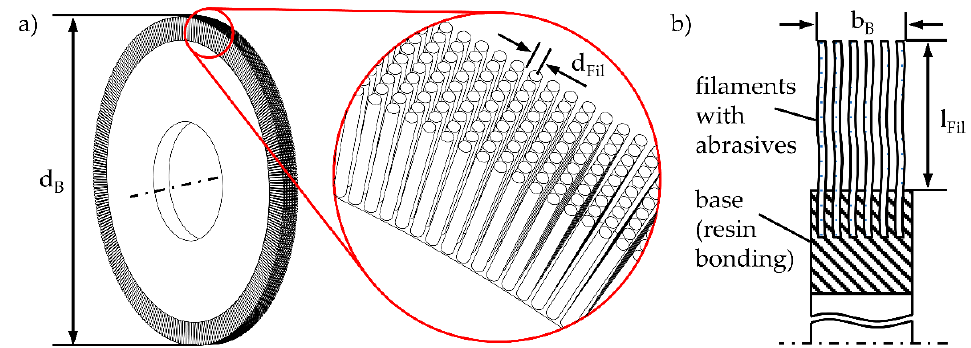
Figure 2. Design of an abrasive brushing tool; ( a ) 3 ‐ D representation of a cast round brush with abrasive filaments; ( b ) Schematic cross ‐ section of the brushing tool.